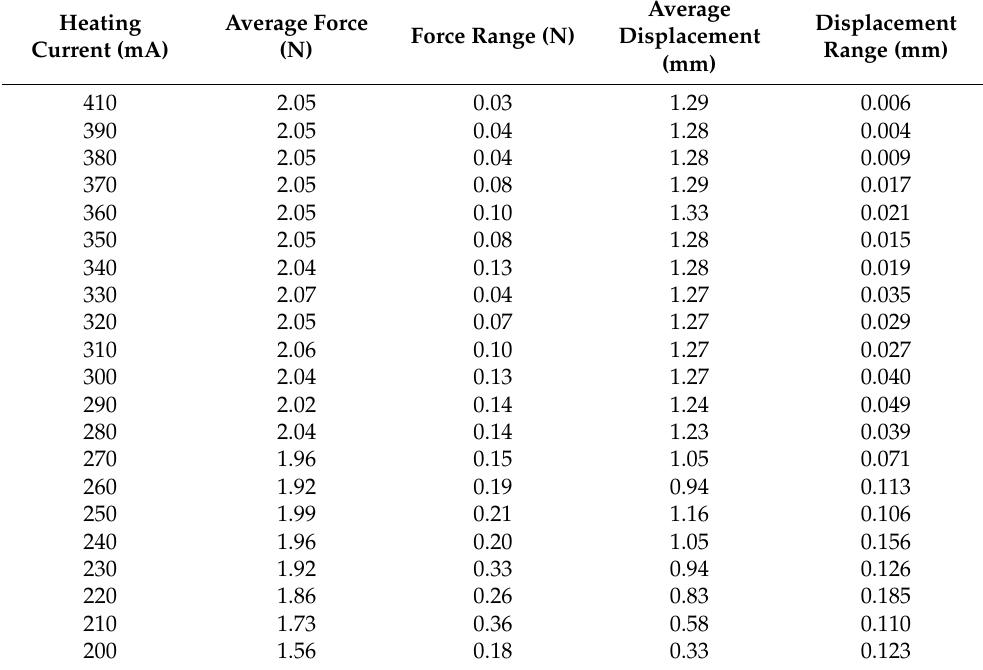
Table 4. Statistical properties of the measurement data with different heating currents. Sample diameter, 150 µ